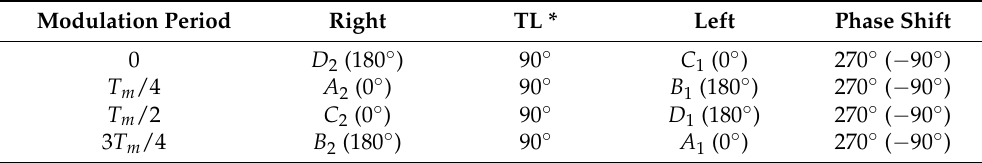
Table 3. Phase shift in reverse direction.